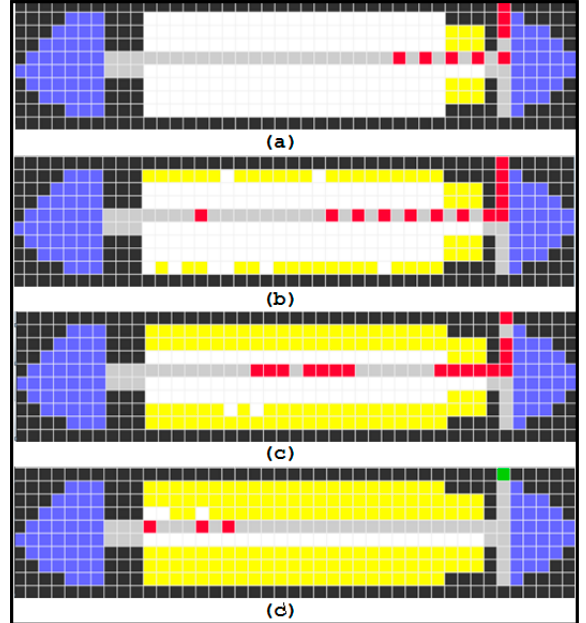
Figure 23. Window Middle Aisle (WMA) strategy.